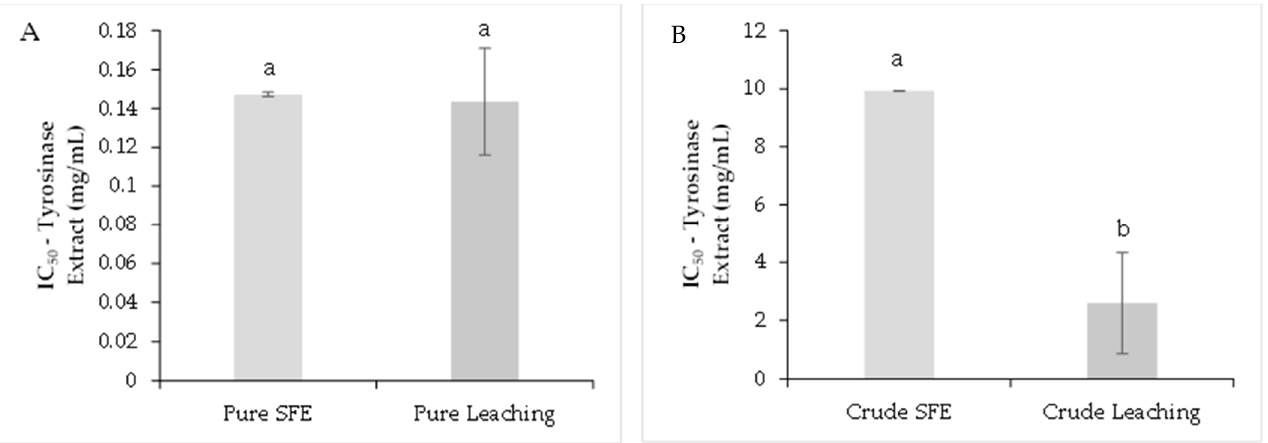
Figure 2. ABTS antioxidant capacity analysis. Purified extracts ( A ), crude extracts ( B ). The results are shown as mean ± standard error. Different letters indicate significant differences among treatments ( p < 0.05) (Tukey’s HSD post hoc analysis).